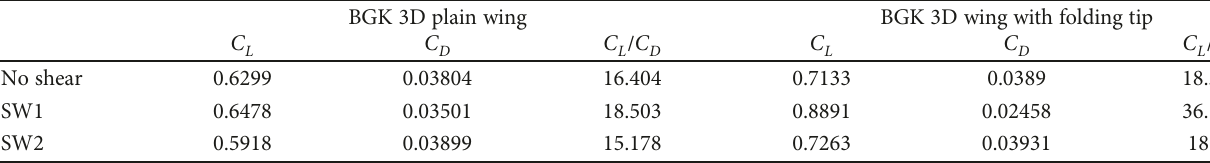
Figure 16: BGK wing with folding tip at Table 2: Lift and drag coe ffi cients with and without folding tips.